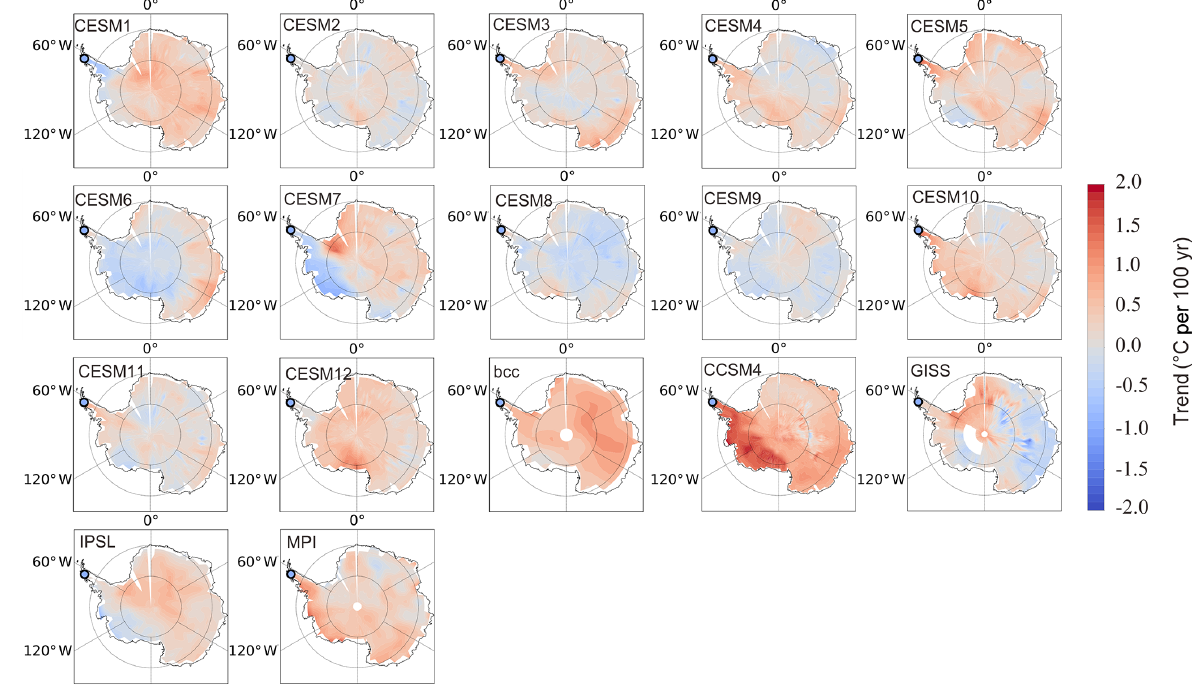
Figure 9. The simulated (blue to red shaded area) and observed (circle) surface temperature trend from 1825 to 1925CE.